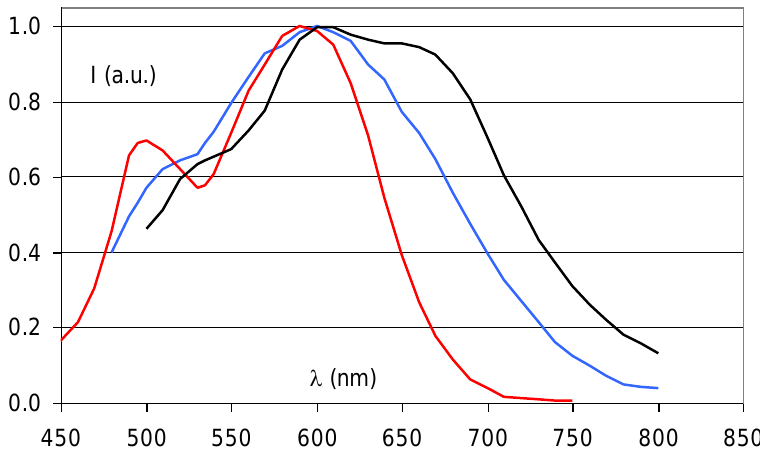
Figure 12. Stimulation spectra of BaFBr from [27]) and BaFBr:Eu 2+